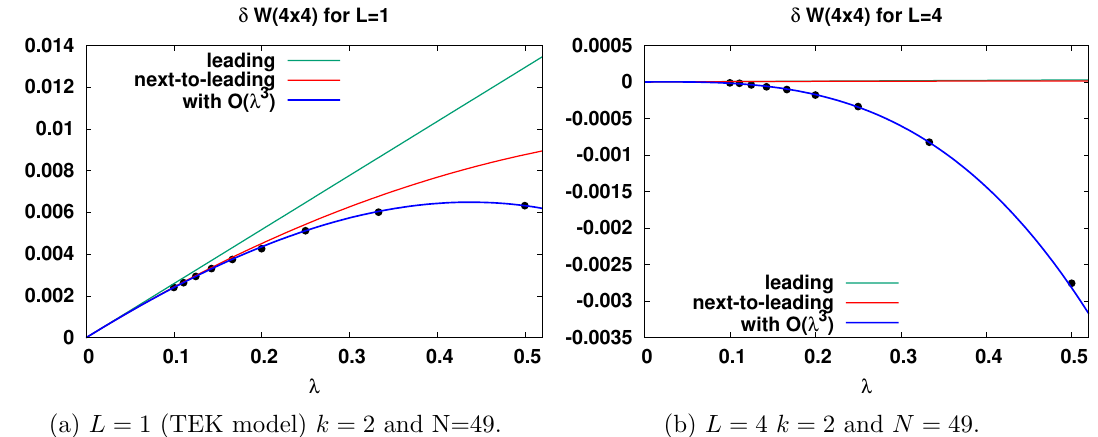
Figure 8. We display the Monte Carlo measured value of the real part of the 4 (cid:2) 4 loop for the twisted N = 49 model on an L 4 box minus the prediction of perturbation theory at in(cid:12)nite volume and in(cid:12)nite N up to order (cid:21) 2 (eq. (6.1)). The di(cid:11)erence is compared with the predictions of this paper at leading and next to leading order and a (cid:12)t including a (cid:21) 3 correction. The left and right sub(cid:12)gures correspond to L = 1 (TEK model) and L = 4 respectively. For L = 4 leading and next to leading lines